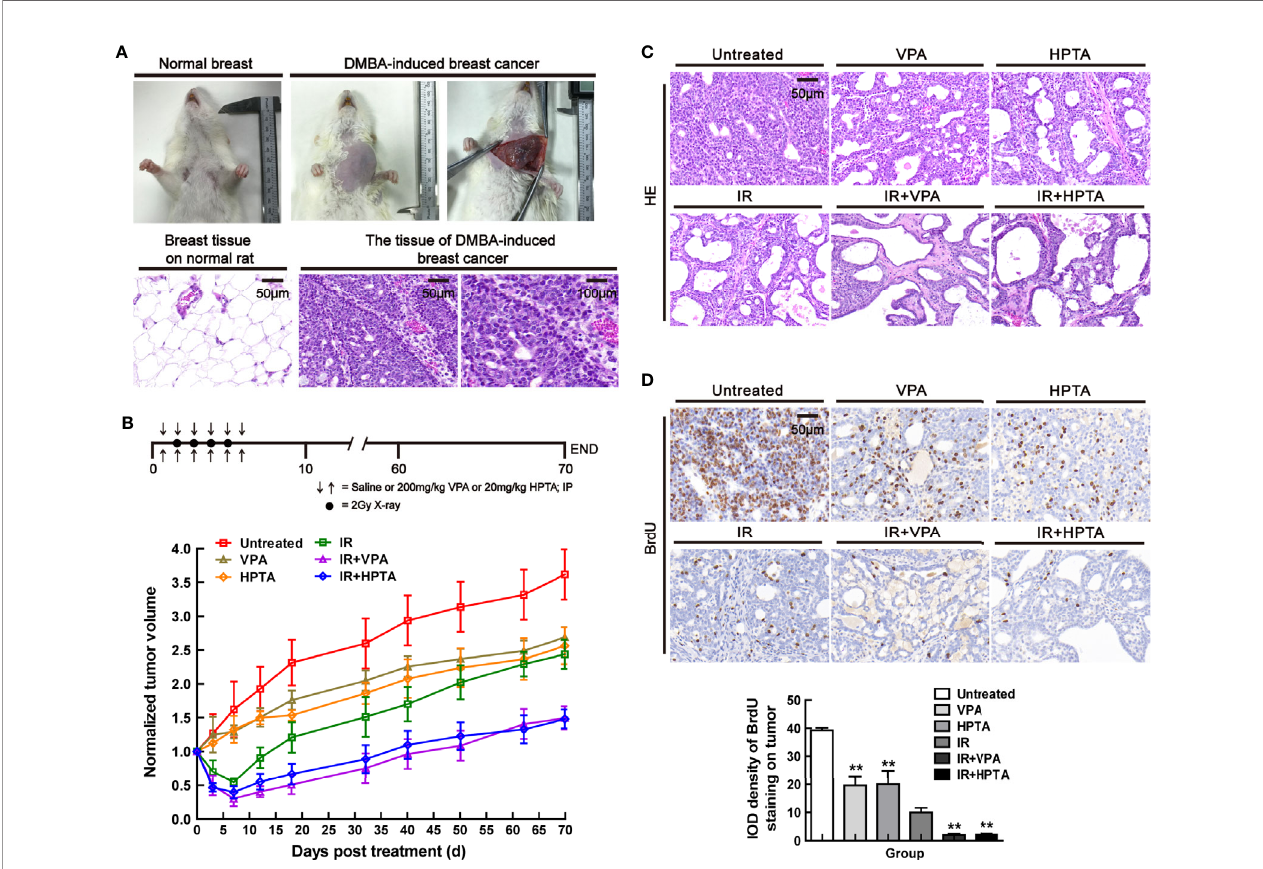
FIGURE 1 | VPA/HPTA enhanced radiotherapy effect to inhibit tumor growth in rats with breast cancer (A) Normal breast and DMBA-induced breast cancer of rats under gross observation. HE staining for the morphology of normal tissue and DMBA-induced breast cancer. (B) The tumor-bearing rats were given intraperitoneal injection of saline, 200 mg/kg of VPA or 20 mg/kg of HPTA twice a day for 6 consecutive days in combination with 2Gy of radiotherapy once a day for 4 consecutive days. The change in tumor volumes in different groups after treatment, which was normalized by untreated group. (C) HE staining for the morphology of tumors in different groups. (D) IHC was performed on tumor sections with BrdU, a marker of proliferation. Quantitation as a percentage of total tissue is shown to the right of representative images. Each data point in the graphs was from three independent experiments (mean ± SD). P -values were calculated by Student ’ s t-test (* P < 0.05, ** P <